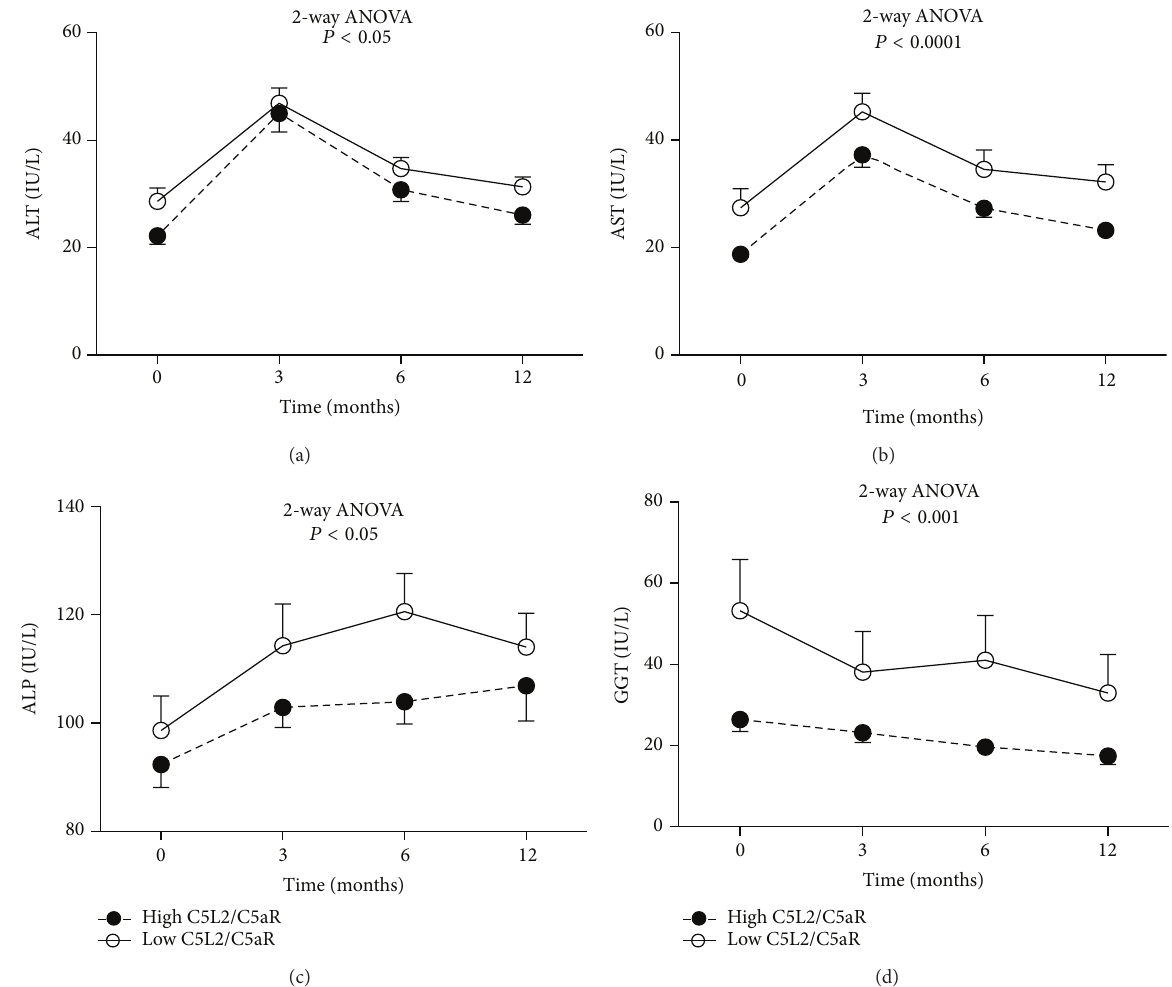
Figure 5: Plasma liver enzyme levels relative to C5L2/C5aR Expression. ((a)–(d)) Plasma liver enzyme levels before surgery and during one year following surgery in high versus low C5L2/C5aR mRNA ratio subgroups, 2-way ANOVA